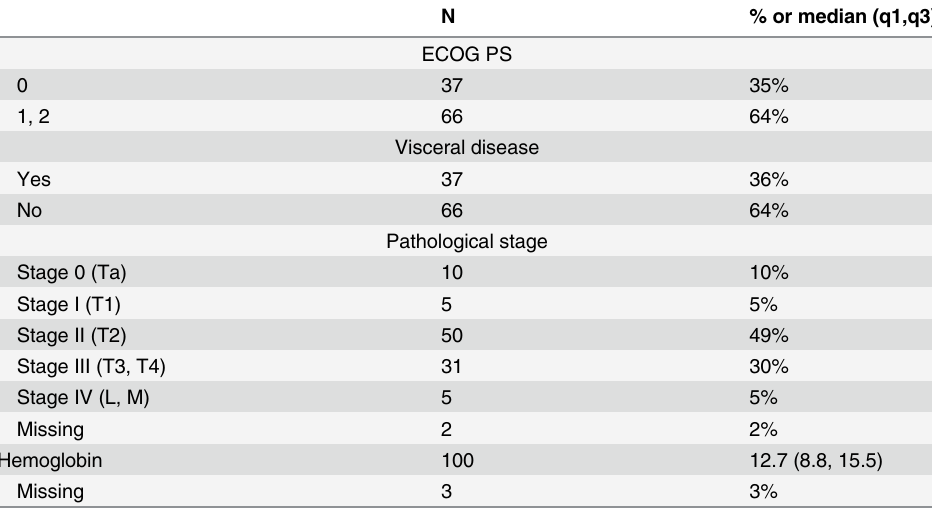
Table 1. Patients and Clinical